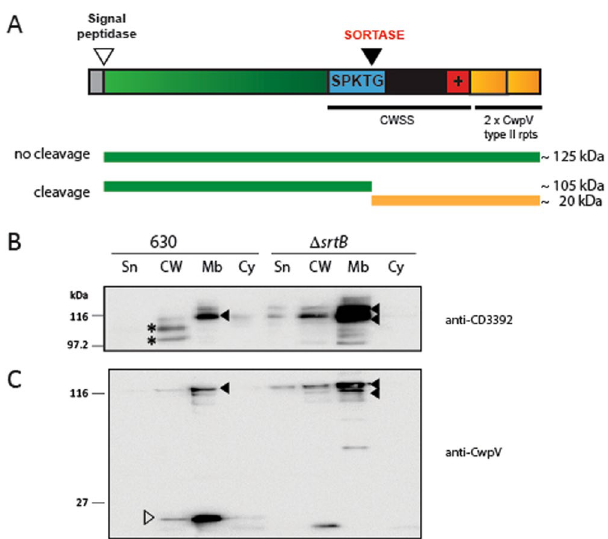
Figure 2. Sortase cleaves fusion protein CD3392-CwpV for cell wall attachment. ( A ) Schematic representation of CD3392-CwpV fusion protein and the predicted cleavage products. Structural domains of CD3392 are as in Fig. 1, with additional Type II CwpV repeats at the C-terminus (yellow). The ~125 kDa green bar represents uncleaved CD3392-CwpV fusion protein, while a green (~105 kDa) and yellow (~20 kDa) bars indicate predicted cleavage products following sortase activity. ( B , C ) Cells of wild type 630 and the Δ srtB mutant carrying pJKP048 and expressing the CD3392-CwpV fusion protein were fractionated into supernatant (Sn), cell wall (CW), membrane (Mb) and cytoplasm (Cy). Protein fractions were analysed by western blot using antibody against CD3392 ( B ) or against CwpV Type II repeats ( C ). ◀, uncleaved CD3392-CwpV; * , large CD3392-CwpV cleavage product; ▷, 20 kDa fragment containing CwpV repeats. Western blots were cropped for clarity; uncropped images can be found in Supplementary Fig.